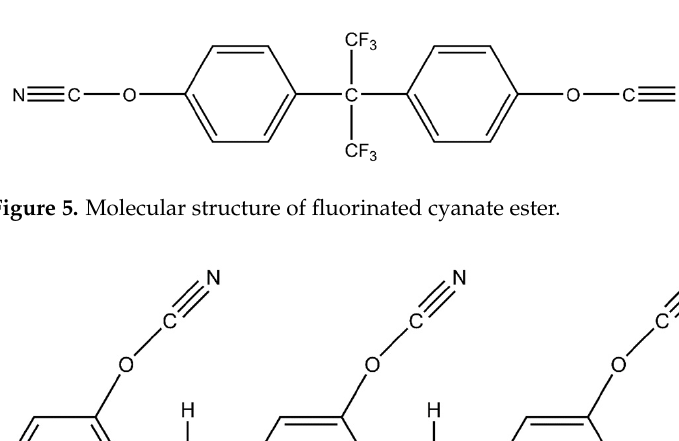
Figure 5. Molecular structure of fluorinated cyanate ester. Figure 6. Molecular structure of non-fluorinated cyanate Figure 6. Molecular structure of non-fluorinated cyanate ester.